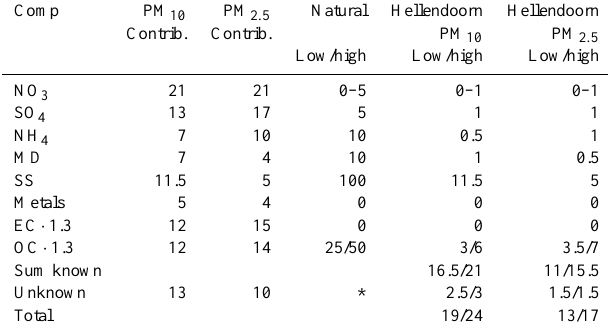
Table 5. Illustration of natural contribution (in %) for all compo- nents in the case of Hellendoorn. For each component the relative contribution to PM 2 . 5 and PM 10 is listed as well as the estimated natural contribution. The two columns on the right provide the re- sulting natural contribution to PM 10 and PM 2 . 5 for each component for a high and low estimate of the natural OC content. All numbers are